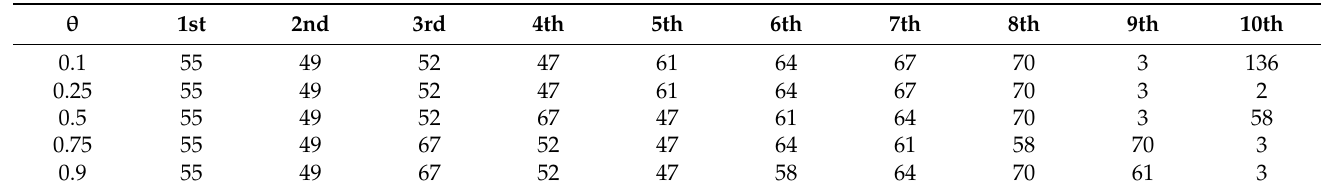
Table 5. Sensibility analysis for the first 10 TTR (technical trading rules) indexes ranked via TODIM. (By the authors.)